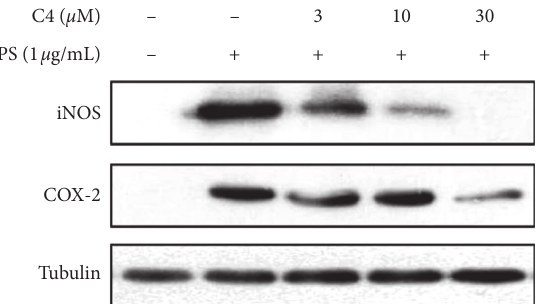
264.7 cells by compound 4 (C4). RAW 264.7 cells were pretreated for 30min at indicated concentrations of 0, 3, 10, and 30 μ M, followed by stimulation with LPS (1 μ g/mL) for 24h. Whole-cell lysates were blotted with the indicated antibodies. α -tubulin level was used as a loading control. The expression levels of iNOS and COX-2 were determined by the analysis of